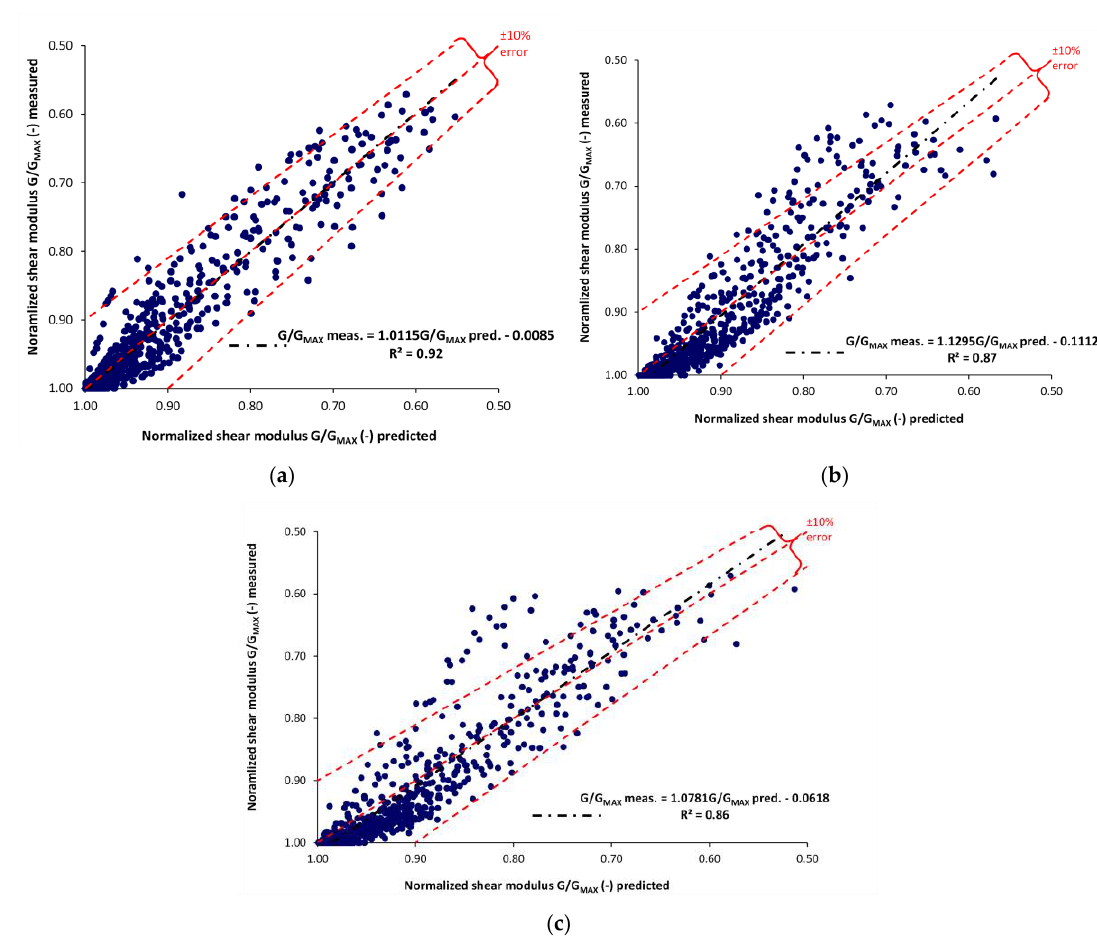
Figure 8. Measured versus predicted normalized shear modulus by empirical models purposed by ( a ) the authors of this article and ( b ) Darendeli [5] and ( c ) Vardanega and Bolton [29].